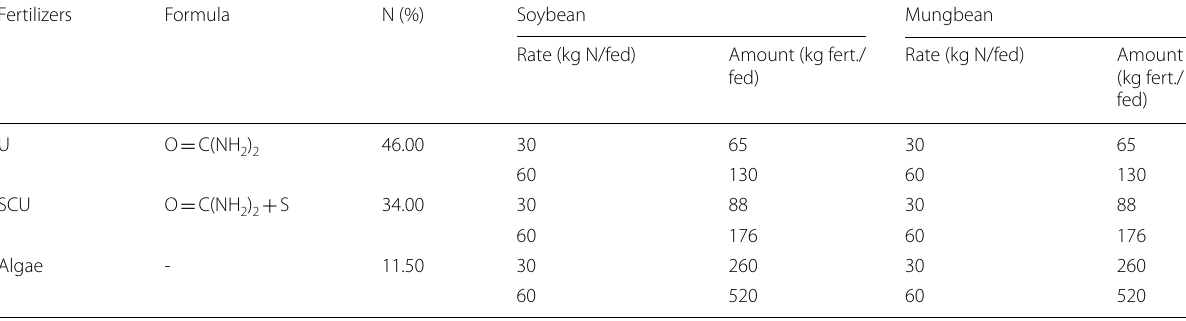
Table 4 Rates of application (kg N/fed) and total amount of fertilizers Fertilizers Formula N